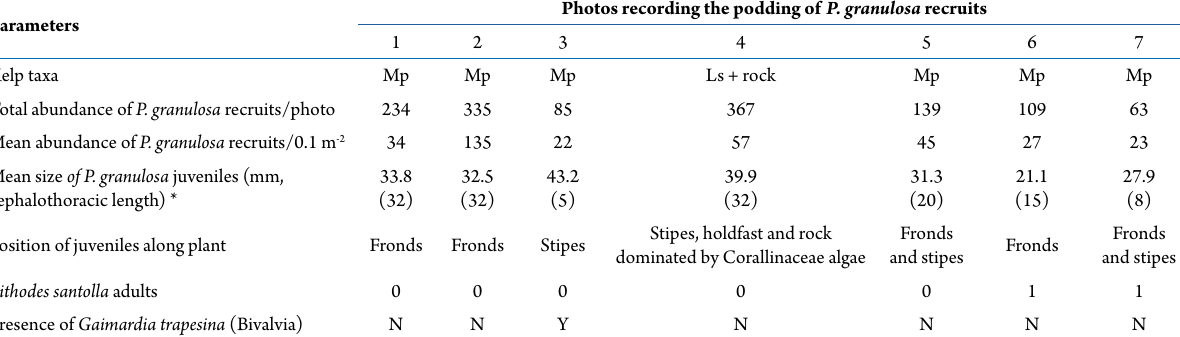
Table 2. Quantitative data regarding the relationship of two sub-Antarctic kelp species and recruits of the false king crab Paralomis granulosa during a survey at Wollaston Island, Cape Horn Archipelago, southern Chile (date: February 9, 2017; 10 m depth). All data were obtained from subtidal photography (N = 7 photos) on two kelp forest species. Some photographs of podding (columns 1–7) are showed in the Fig. 2a–e . Mp = Macrocystis pyrifera; Ls = Lessonia spp.; N = No; Y = Yes; * = values in parentheses indicate standard